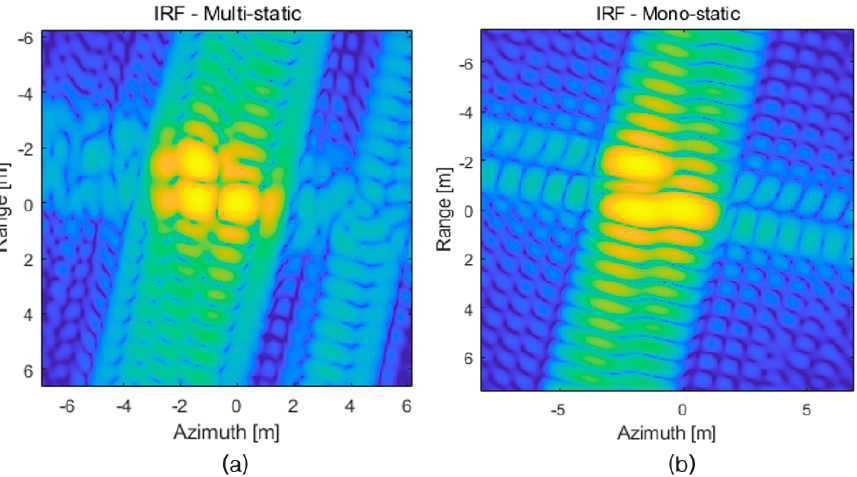
Figure 25. Near-multi-target imaging simulation results of a multistatic SAR system ( a ) and monostatic system ( b ).